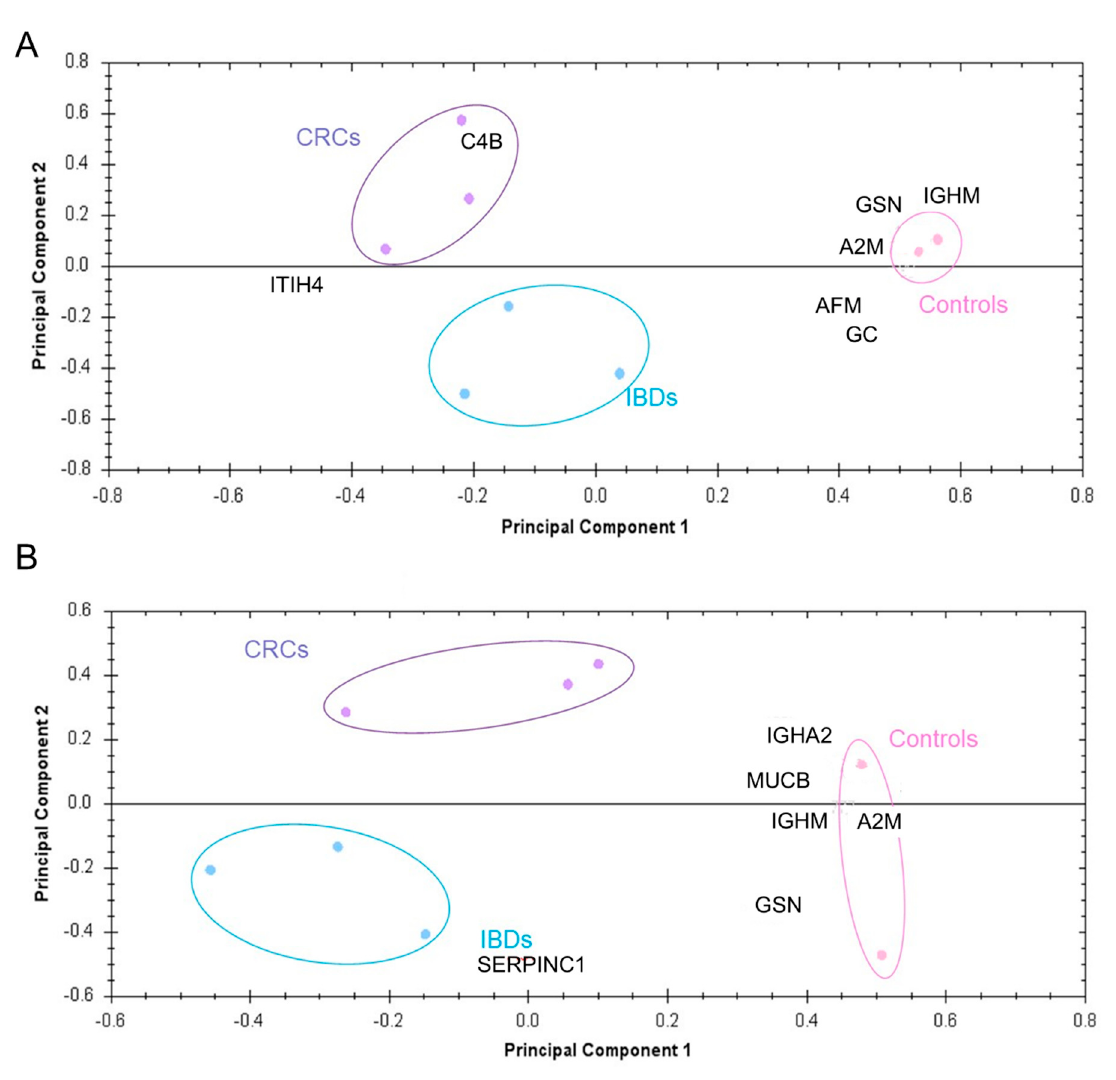
Figure 3. PCA plots based on identified proteins between clinical control (in pink), IBD (in blue) and CRC (purple) EV pellet samples isolated by ( A ) ultracentrifugation (n = 7) and ( B ) ExoQuick ™ (n = 6).